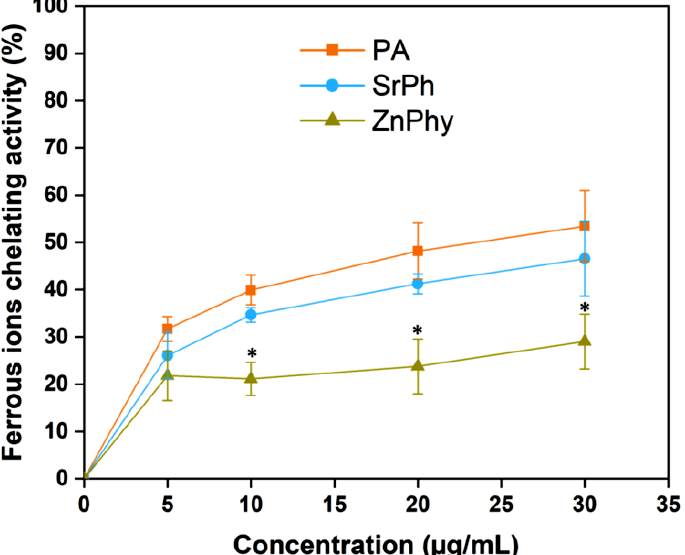
Figure 2. Ferrous complex formation capacities of PA, SrPhy and ZnPhy at different concentrations in the presence of ferrozine. Statistical differences between samples at each concentration were assessed (* p < 0.05) using an ANOVA test (Tukey’s means comparison). Data are represented as the mean value (%) ± SD. The experiment was conducted with triplicate samples.